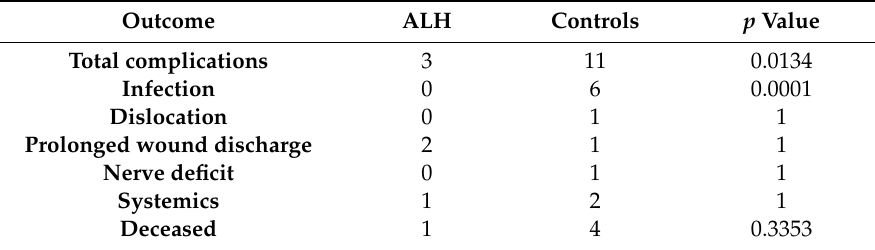
Table 4. Complications and deaths.